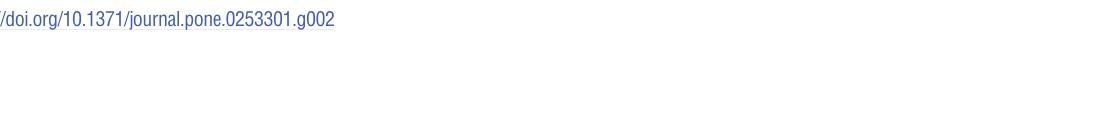
PLOS ONE | https://doi.org/10.1371/journal.pone.0253301 June 30,